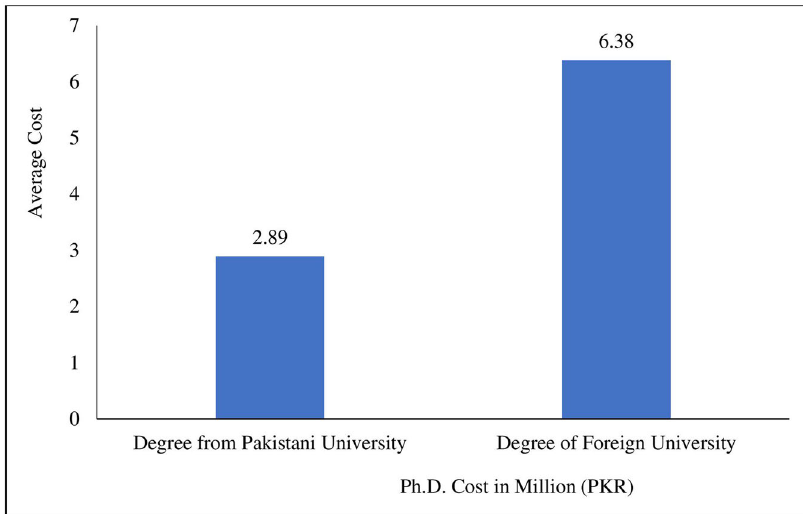
Fig. 7 Country-wise average cost of Ph.D. degree. It shows the explicit and implicit costs (combined) of doing a Ph.D. from Pakistani universities compared to foreign universities. The cost of obtaining a Ph.D. from a foreign university is more than double that of a domestic university.